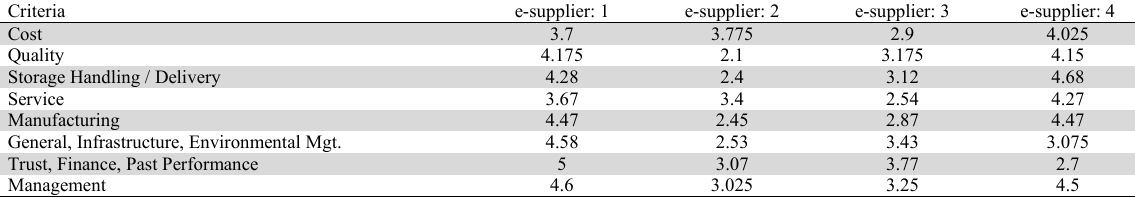
Aggregated Average Performance Ratings of e-suppliers